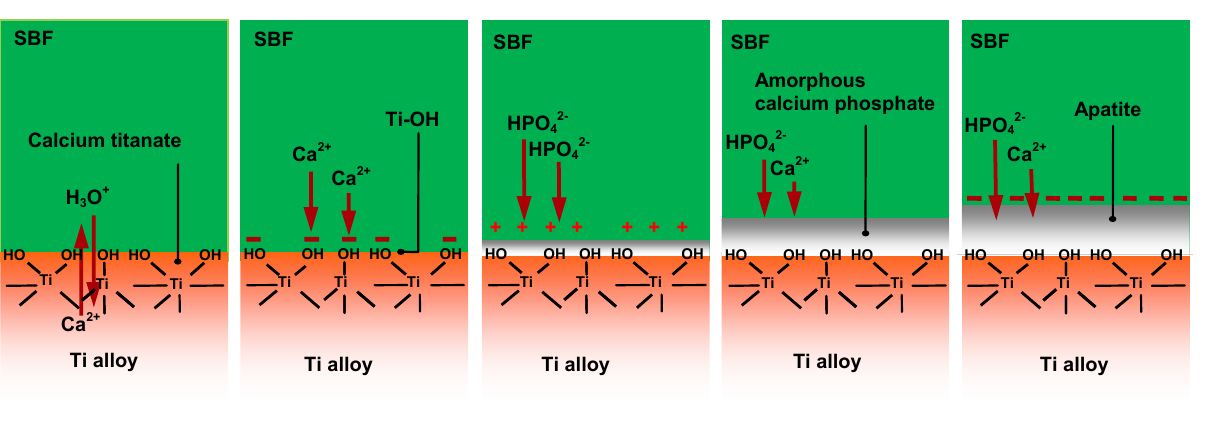
Figure 18. Process of apatite formation on Ti-15Zr-4Nb-4Ta alloy subjected to NaOH, , heat and water treatments in CaCl 2